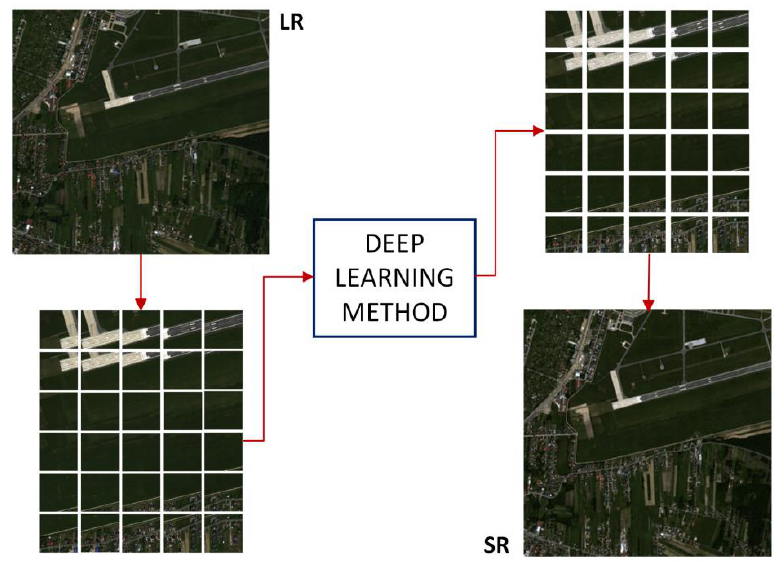
Figure 1. Diagram illustrating the process of improving the resolution of satellite imagery.